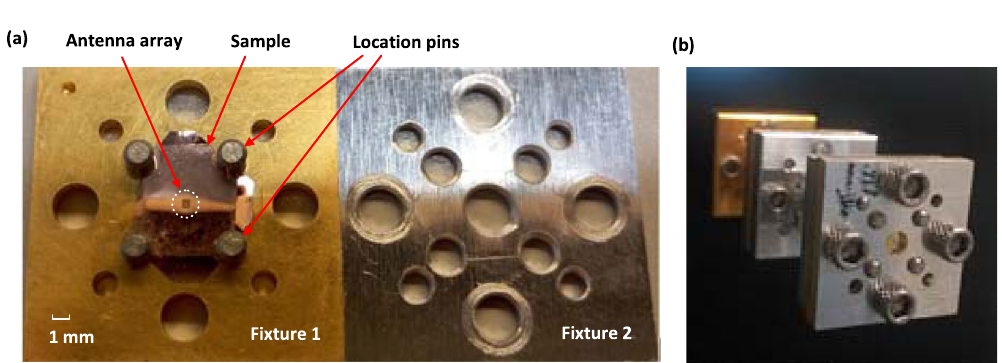
Figure 9. Geometry of the fabricated prototype for measurement. ( a ) Photographs of the fabricated prototype and ( b ) prototype under